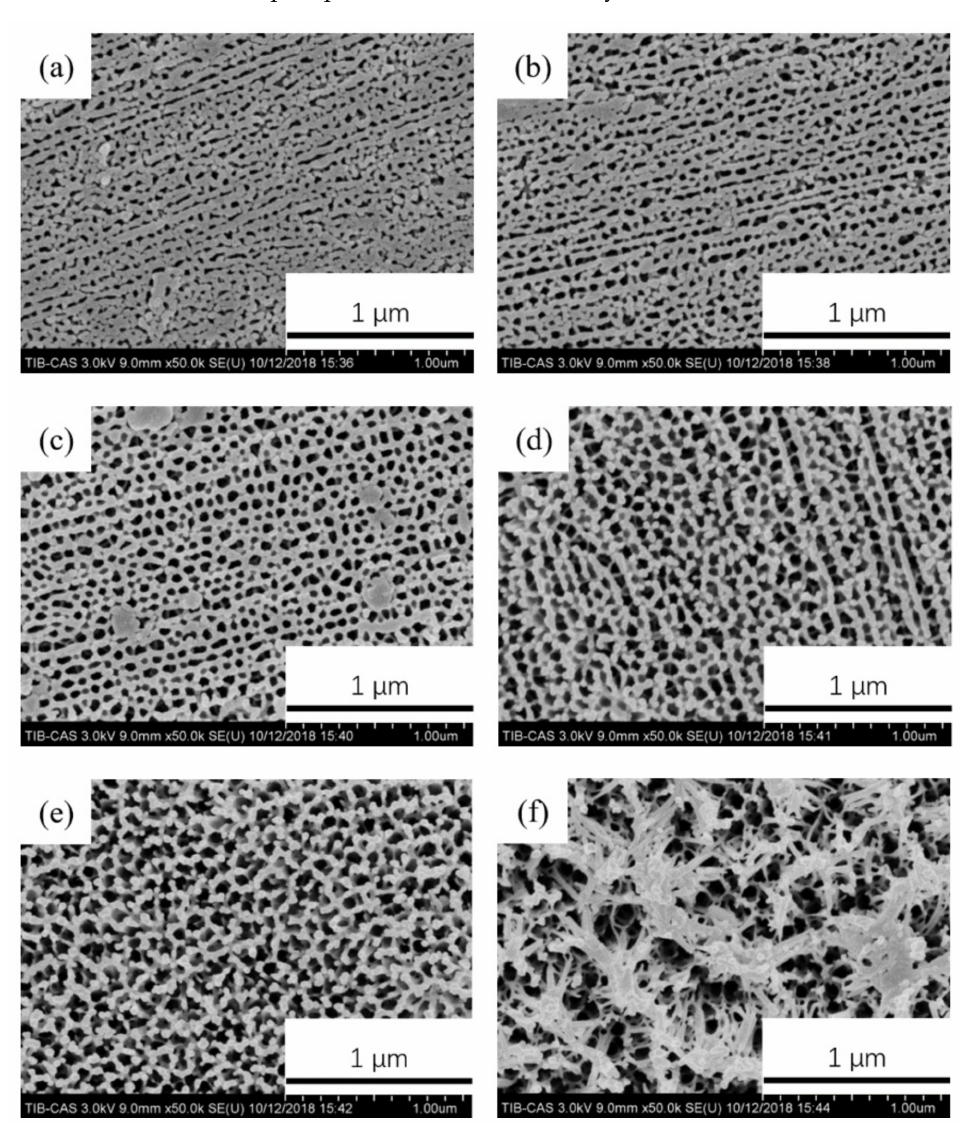
Figure 2. SEM images of 1060 anodic oxide films at different anodic oxidation times: ( a ) 15 min; ( b ) 30 min; ( c ) 45 min; ( d ) 70 min; ( e ) 90 min; ( f ) 120